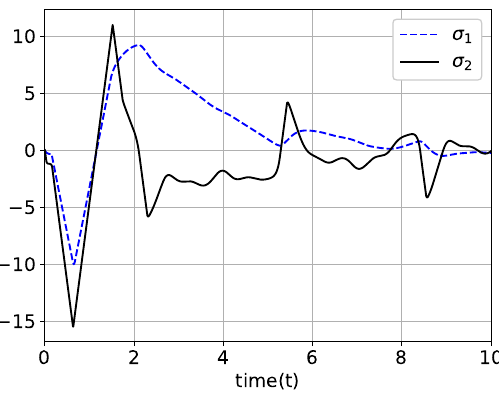
Figure 10. The proposed HOSD: trajectories of σ 1 and σ 2 .